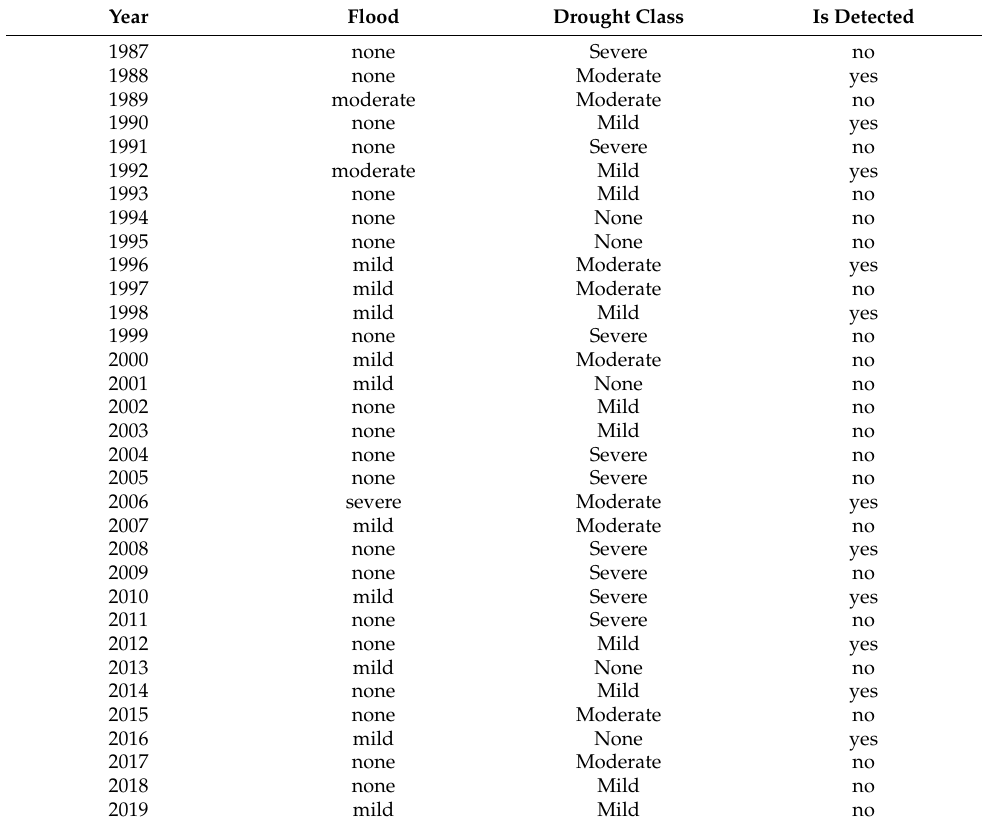
Figure 12. Precipitation and drought for 1987–2019. ( a ) Maximum precipitation and flood threshold for 10 consecutive days and ( b ) proportion of drought periods. Table 2. Occurrence of floods, droughts, and changes detected by the IST-cube for 1987–2019.